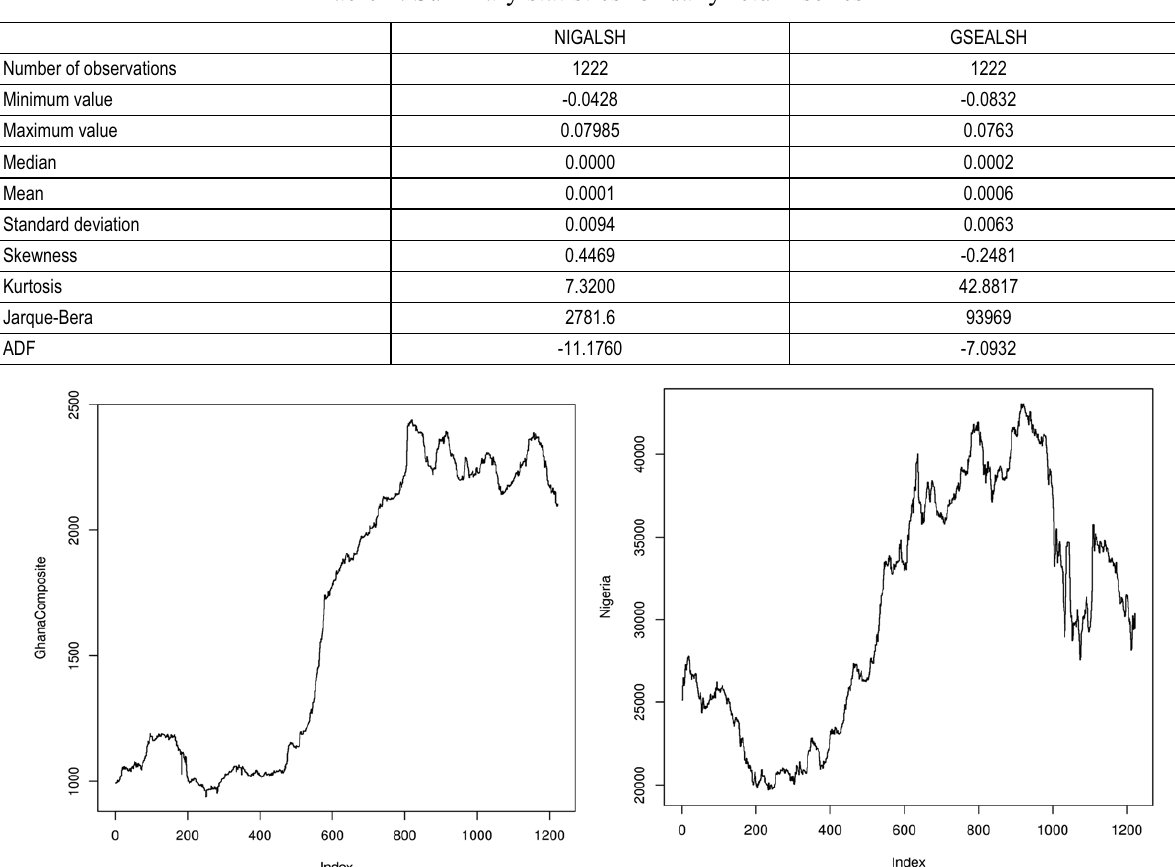
Table 1. Summary statistics for daily return series (cid:3)